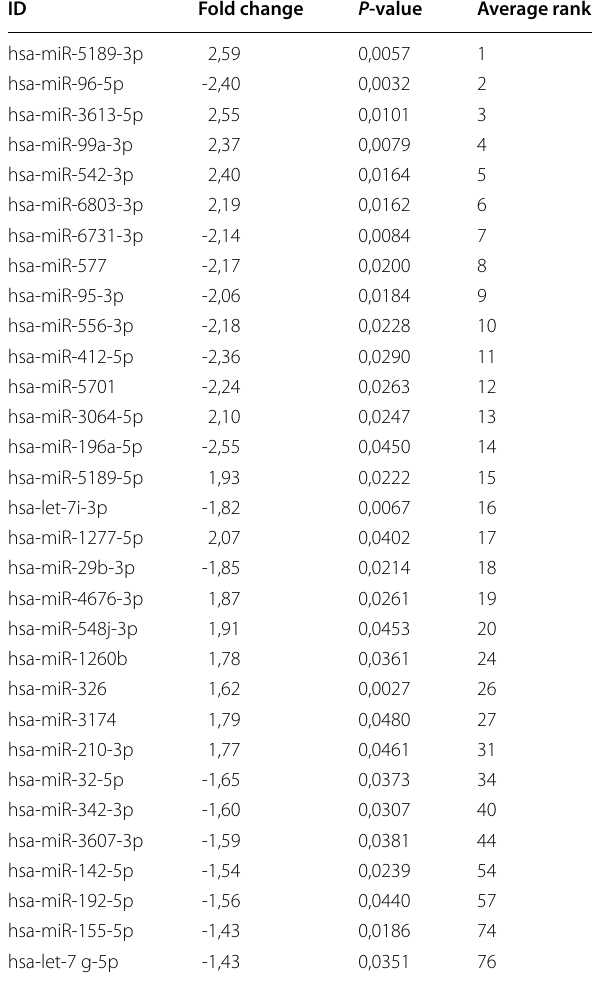
Table 2 DE miRNAs in interictal PBMC samples compared to healthy ones. Differential expression was tested against a fold change threshold of 1.2 and a p -value threshold of 0.05. Average rank was calculated as the mean ranks of miRNAs based on fold change and